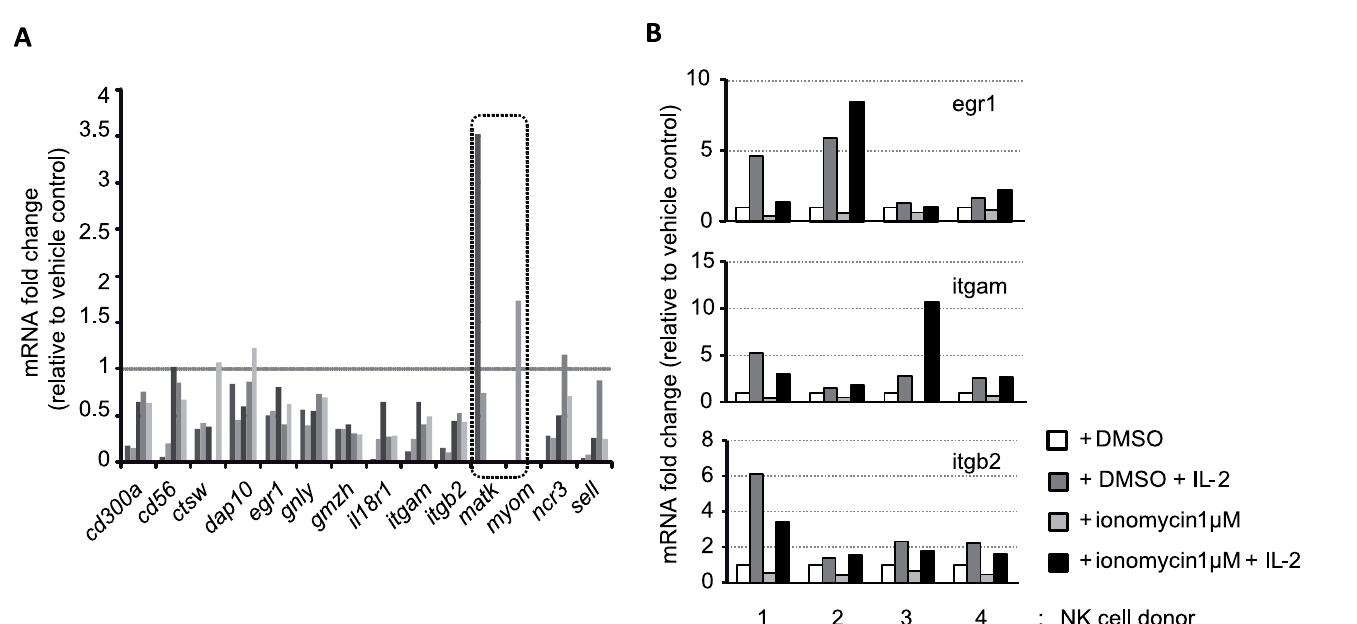
Fig 6. Genetic analysis of ionomycin treated NK cells. ( A ) Gene expression analysis by qPCR of 14 selected genes that appeared downmodulated in the microarray experiment comparing ionomycin treated cells to control cells. ( n = 5). Highlighted genes represent genes that appeared downregulated in the microarray analysis, but were not confirmed by qPCR and so were not analysed further. ( B ) The effect of IL-2 on the expression, by DMSO and ionomycin treated NK cells, of the genes analyzed previously was analyzed by qPCR. IL-2 rescued the levels of expression of egr1 , itgam and itgb2 genes in all 4